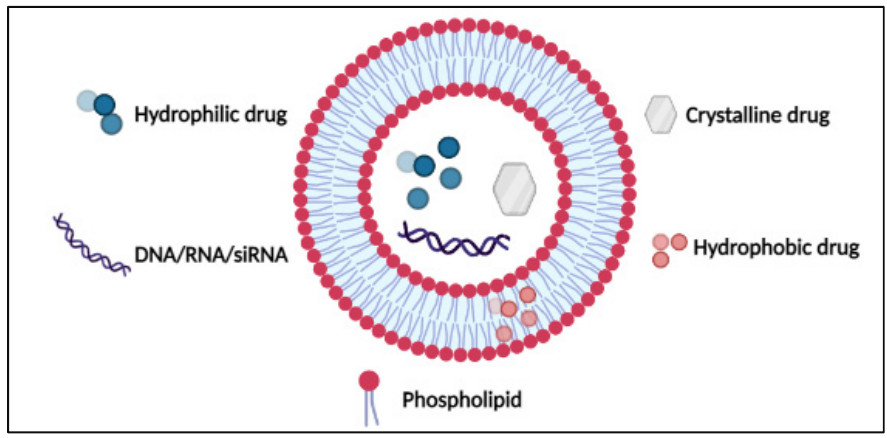
Figure 4. Structure of liposomes. Reproduced from [46], IntechOpen, 2014.